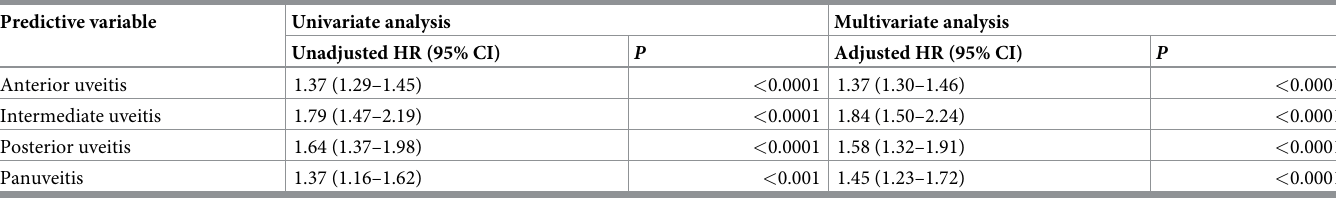
Table 3. Risk for PS and PSA in patients with different types of uveitis.